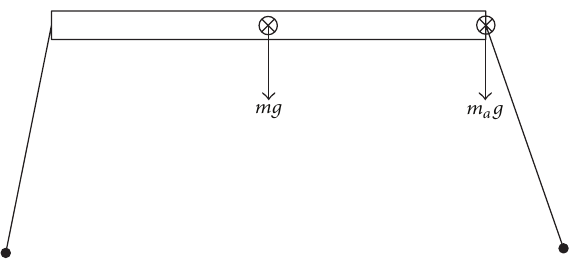
Figure 20: The diagram of force analysis when the carnivores hold a prey in the mouth.